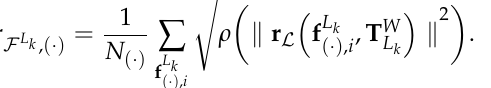
( c ) Figure 11. The map is generated by LC-LIO-AC in the urban canyon 1 and rendered with intensity value. ( a ) The entire map in bird-eye view. ( b ) The top panel is the zoomed-in map around the first place marked in ( a ), the bottom panel is the zoomed-in map around the second place marked in ( a ). ( c ) The top and the bottom panels are the environments that correspond to the first and the second place, respectively. As shown in Figure 12, there is an obvious contrast between both maps generated by LC-LIO-AC with and without the coarse-to-fine process. When the vehicle passes the same place the second time, the map generated by LC-LIO-AC with the coarse-to-fine process is more clear while that generated by LC-LIO-AC without the coarse-to-fine pro- cess suffers blur. The proposed coarse-to-fine process of LC-LIO-AC, which provides an